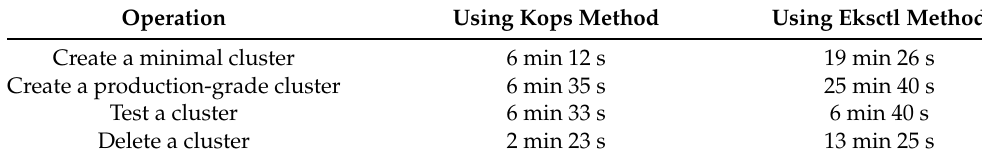
Table 1. Time needed to run Kubernetes management operations using kops and